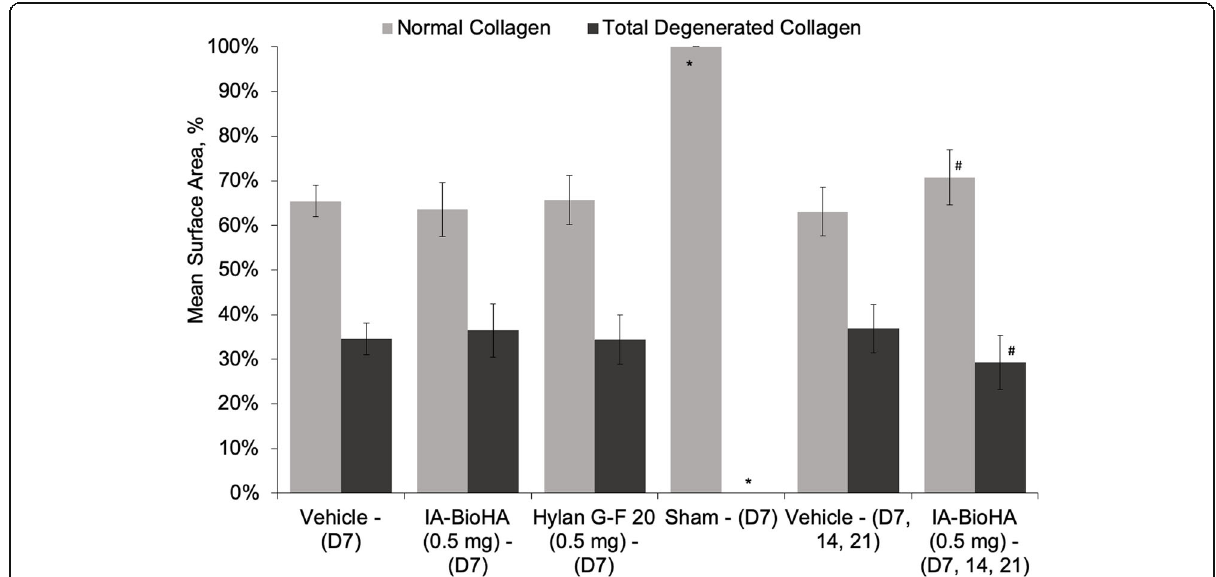
Fig. 2 Histological scoring for tibial collagen degeneration and amount of normal collagen. Collagen damage is measured with an ocular micrometer as the width of any collagen damage across the tibial plateau. The mean proportion of the tibial surface that showed either normal collagen or total collagen degeneration is shown. Three weekly injections of IA-BioHA showed a significantly greater amount of normal collagen and significantly smaller amount of total collagen degeneration compared to vehicle control. Error bars indicate 1 standard error from the mean. n = 15/group for test article and vehicle control groups, n = 10/group for sham surgery. * different from the D7 and D7, 14, 21 vehicle control groups, p < 0.0001. # different from the respective D7 or D7, 14, 21 vehicle control p = 0.011